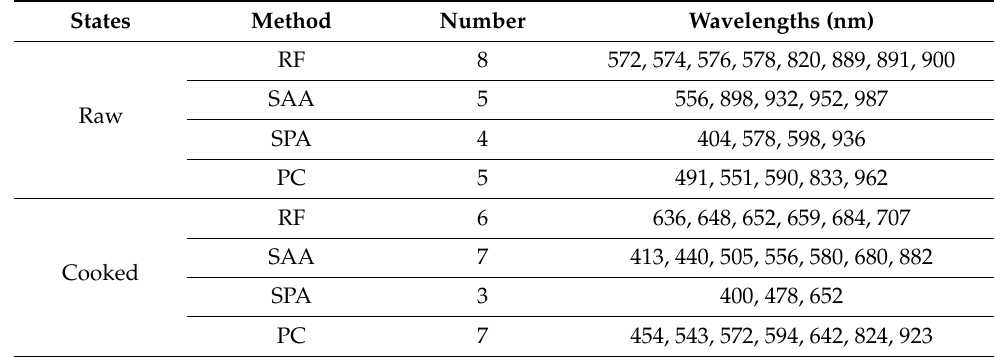
Table 2. Summary of selected wavelengths using RF, SAA, SPA and PC loadings. RF: random frog; SAA: simulated annealing algorithm; SPA, successive projections algorithm; PC, principal component.